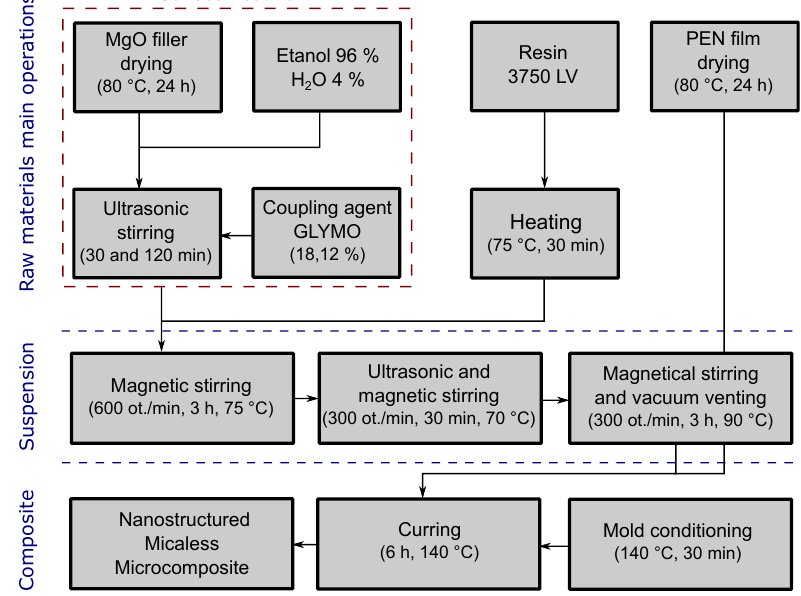
Figure 7. Block diagram of composite